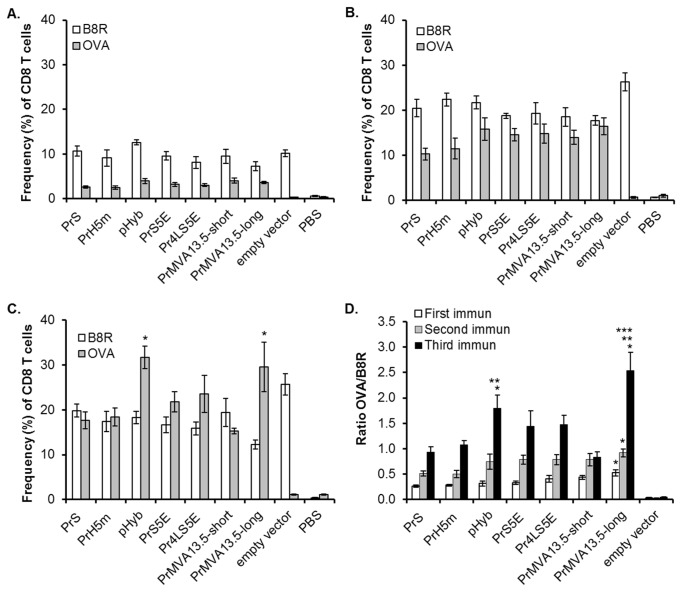
OVA specific CD8 T cell responses.Mice were immunized with different recombinant MVAs expressing ovalbumin (OVA) under the control of the indicated promoters. CD8 T cells from blood were analysed for OVA- and vector- specific responses one week after each immunization by staining for CD8 and CD44 markers along with MHC class I dextramers complexed with the TSYKFESV peptide from the B8R protein or with the SIINFEKL peptide from the OVA protein. CD8 T cells were gated from the lymphocyte population and the frequencies of OVA (gray bars) and B8R (white bars) specific CD8 T cells were obtained as a percentage from the total CD8 T cell population. The frequency of both OVA and B8R specific CD8 T cells were obtained for each mouse and the average for each group calculated. The average frequency of OVA and B8R specific CD8 T cells for each group (+/- SEM) is shown after the first (A), second (B) and third (C) immunizations. *, indicates values with significant difference (p < 0.02) when compared to the PrMVA13.5-short, PrS and PrH5m promoters. (D) The frequencies of OVA and B8R specific CD8 T cells were used to calculate OVA- to B8R- specific (OVA/B8R) ratios for individual mice after each immunization (immun). Values reported are the average for each group. Error bars represent +/- SEM. *, indicates values with significant difference (p < 0.05) when compared to the PrS; **, indicates values with significant difference when compared to the PrMVA13.5-short; ***, indicates values with significant differences when compared to the PrH5m.